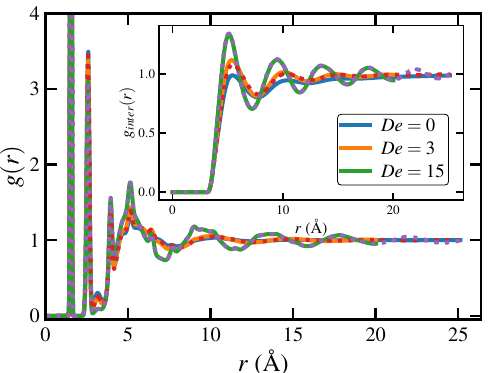
Figure 15. Steady-state radial distribution function, g ( r ) , of the C 1000 H 2002 melt at three values of De = 0.0, 3.0, 15.0 under both UEF (solid lines) and PEF (dotted lines). Note that UEF and PEF data virtually overlap at all De ; therefore, the PEF data curves are not labelled in the legend. The inset displays the intermolecular contribution to the overall RDFs displayed in the main